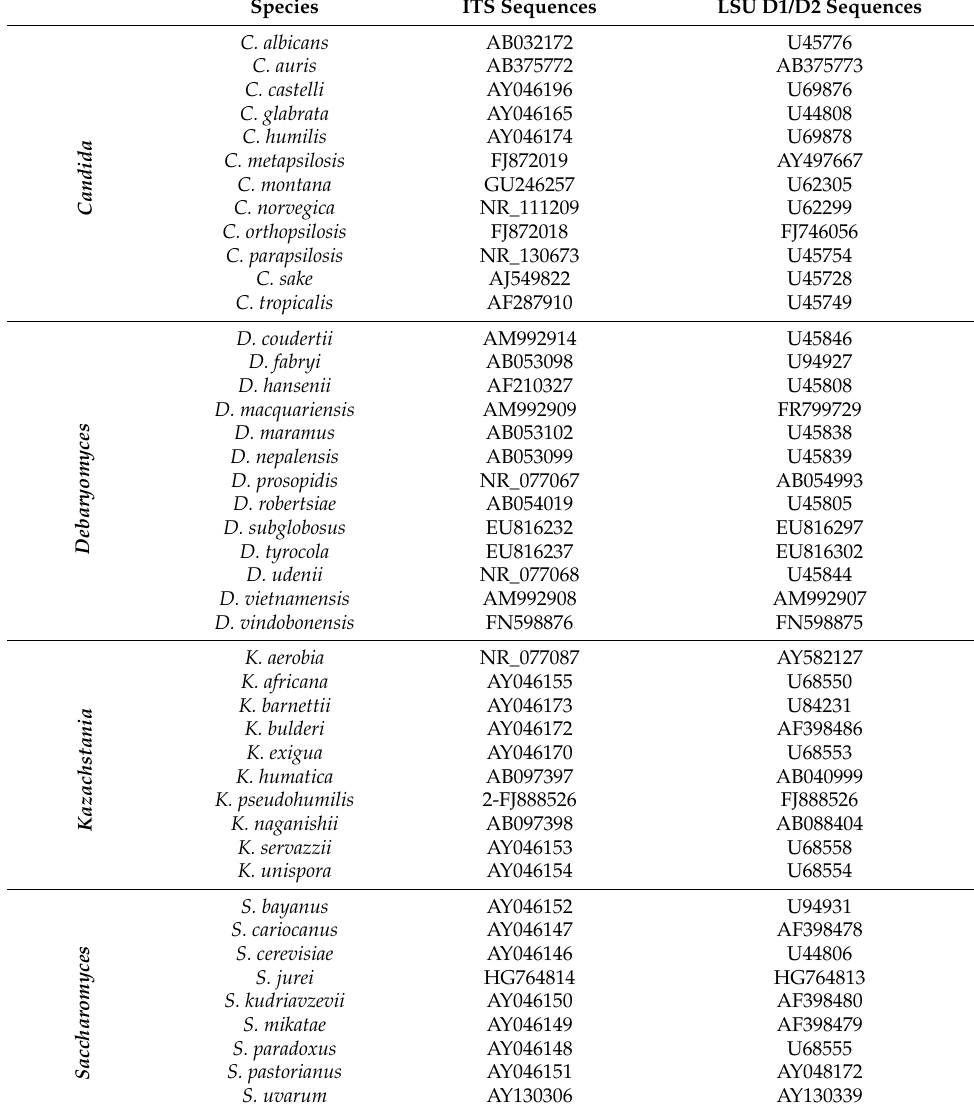
Table 1. Genbank accession numbers of type strain sequences that were used for species level